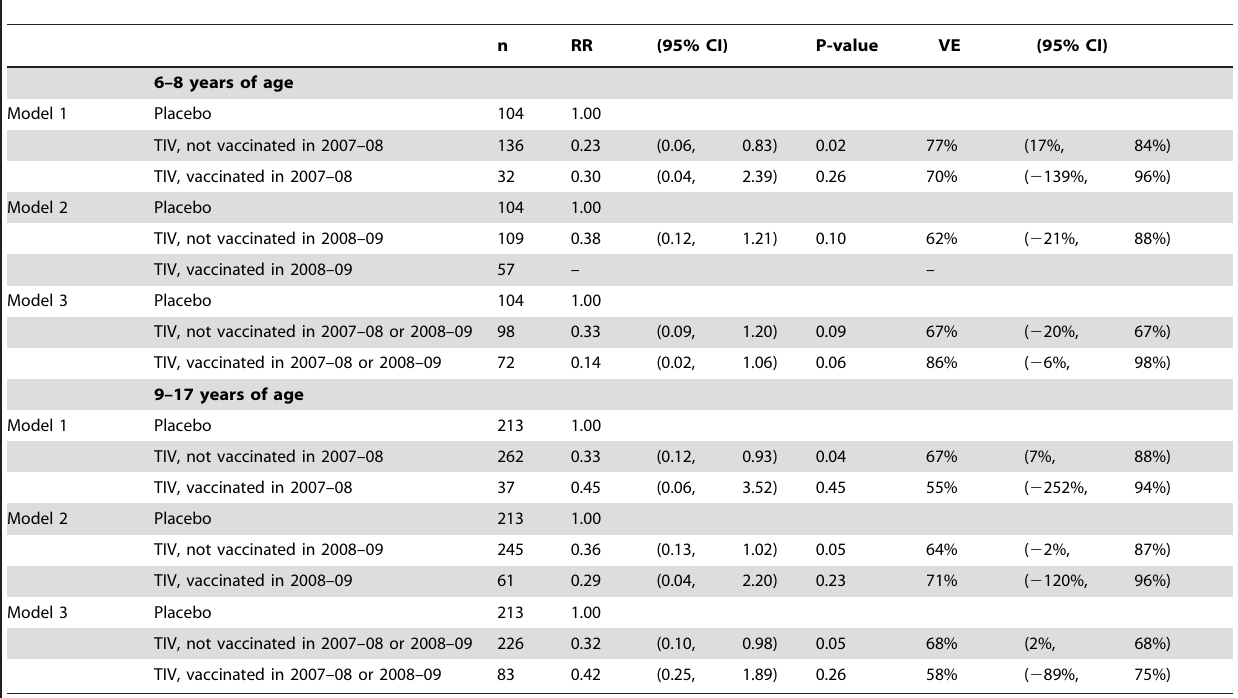
Table 3. Factors affecting risk of RT-PCR confirmed influenza B infection and vaccine efficacy (VE) of trivalent inactivated influenza vaccine (TIV) in